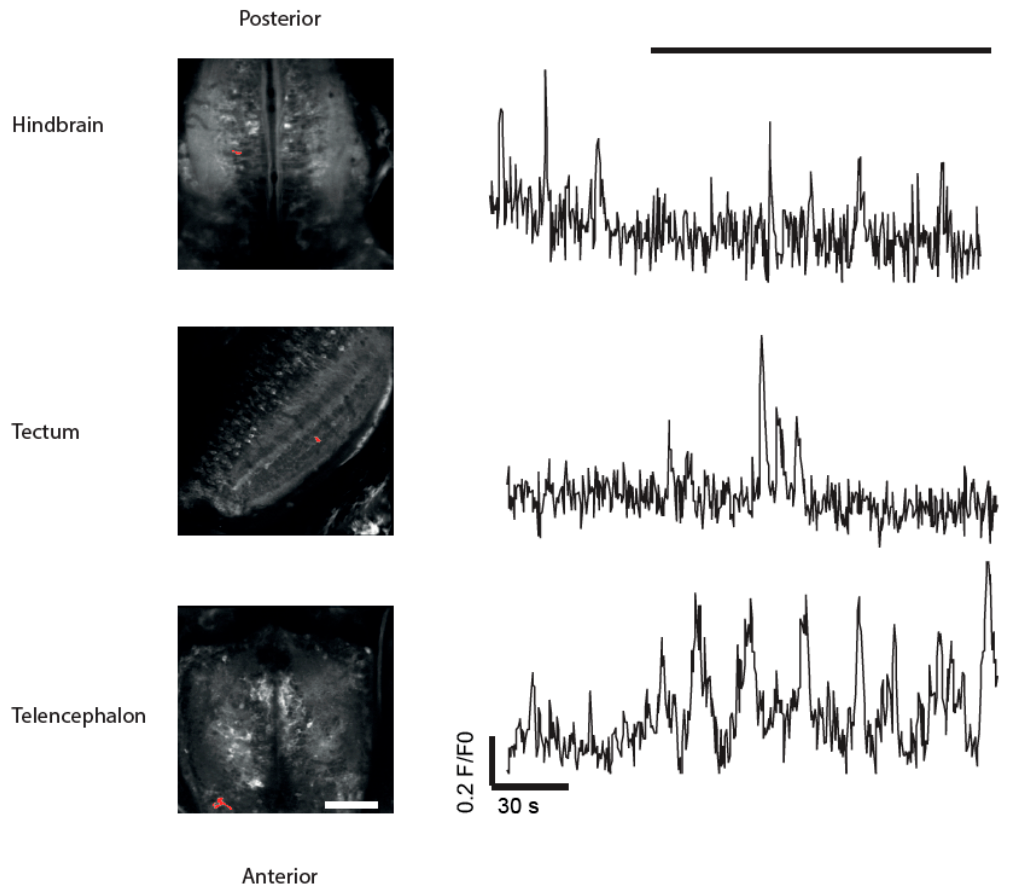
Figure 6. Spontaneous (independent of visual stimulation) activity can be observed in brain areas other than optic tectum using the NBT:GCaMP3 line. Left: Representative images of hindbrain, tectum and the telencephalon of 14 dpf fish used in this experiment. Right: examples of calcium dynamics in individual ROIs in these brain areas. Black bar (top) indicates duration of stimulus (spots moving in rostro-caudal direction). Scale bar = 80 µm. The respective ROIs are highlighted in red. Taken together, these data demonstrate the potential of the NBT:GCaMP3 line for imaging